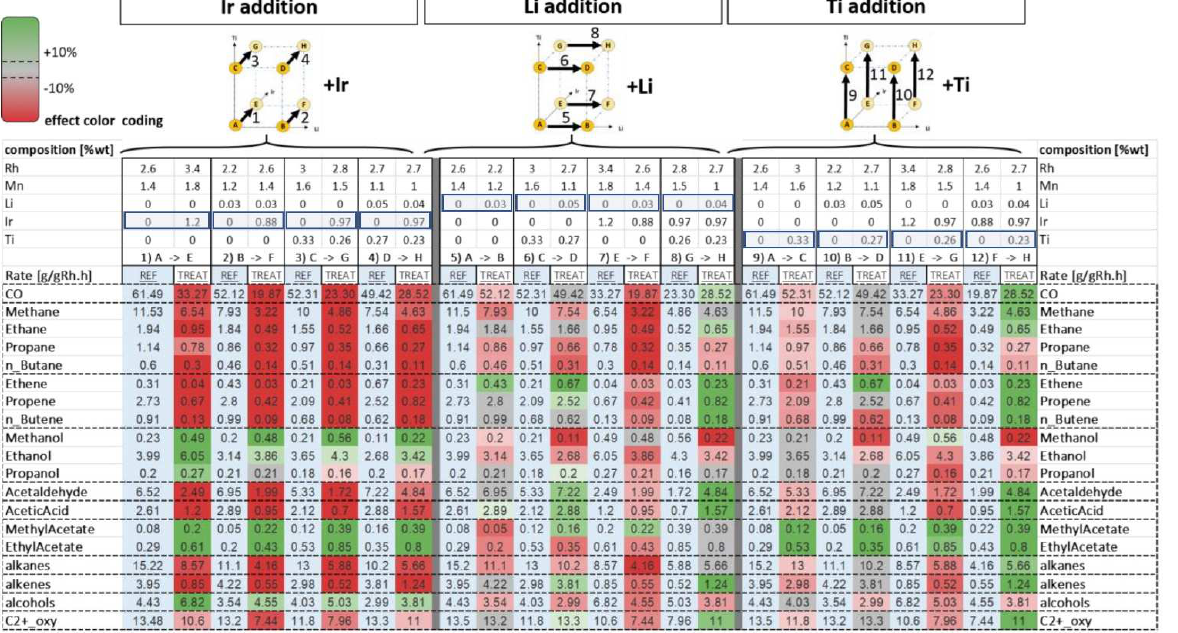
Figure 4. The studied effect of co-promotion via twin-pairing, at Exp 1 (T = 270 °C, P = 50 bar, total flow = 43 mL/min, H2:CO = 48:22 %V). The effect of Ir addition is shown on the left, Li addition in the middle, and Ti addition on the right. Each of the three cubes on the top shows compared twins with black arrows. For each numbered arrow, pointing from the reference catalyst to the treated catalyst, there is a column pair with the same number showing the performance of the reference and treated catalysts. The values for the treated catalyst in each column pair are colored according to changes, respective to the reference catalyst.